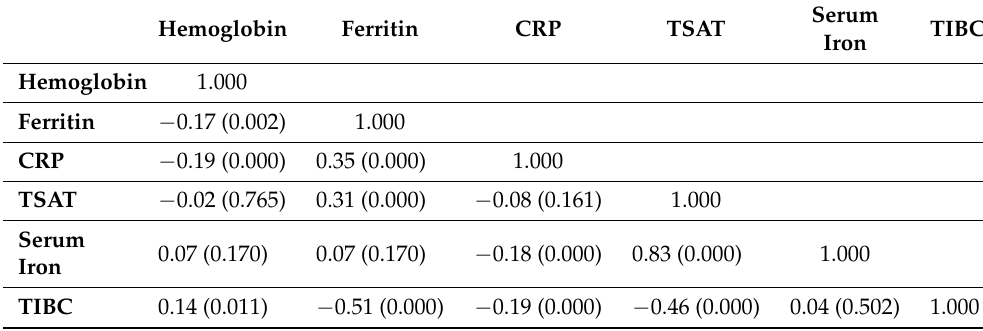
Table A4. Spearman correlation of hemoglobin with iron biomarkers, r coefficient ( p